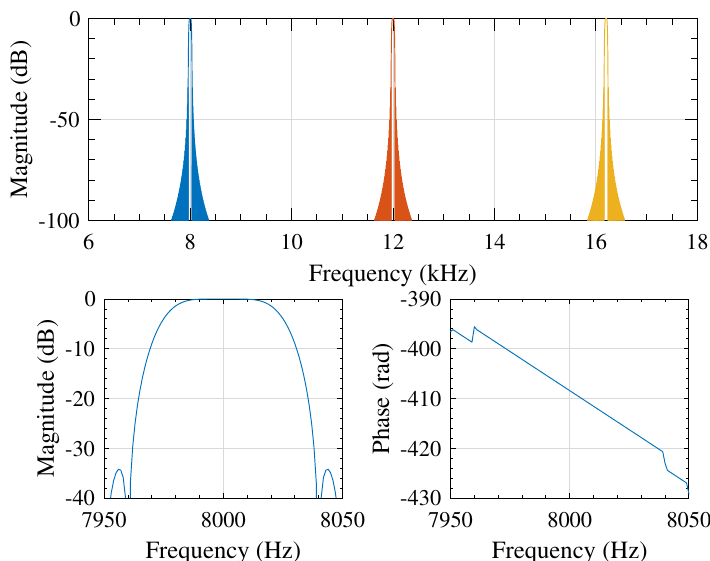
Figure 5. Frequency magnitude responses of the flat-top bandpass Hilbert transformers (FTBPHTs) configured for three working frequencies f 1 = 8 kHz, f 2 = 12 kHz, and f 3 = 16.2 kHz (top), and zoomed magnitude and phase response for the FTBPHT working with f 1 = 8 kHz (bottom). The length of each FTBPHT filter is 40,001 samples. The shapes of magnitude and phase responses of the remaining two filters in passbands are approximately the